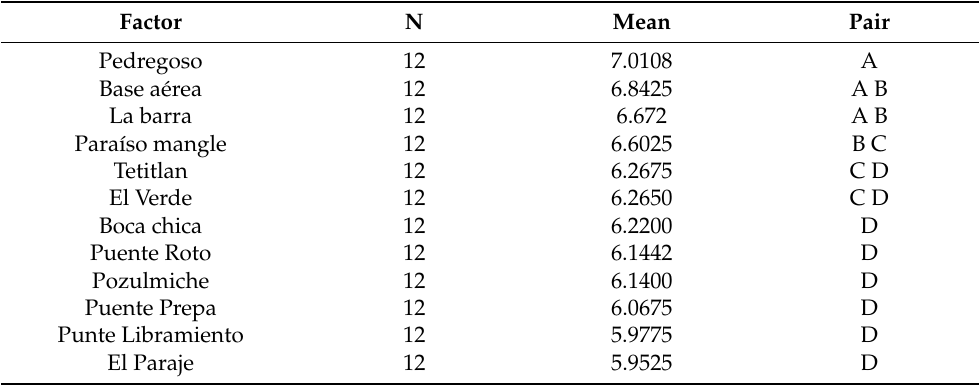
Table 5. Tukey’s pairwise comparisons, grouping of information using the Tukey method confidence of 95%.